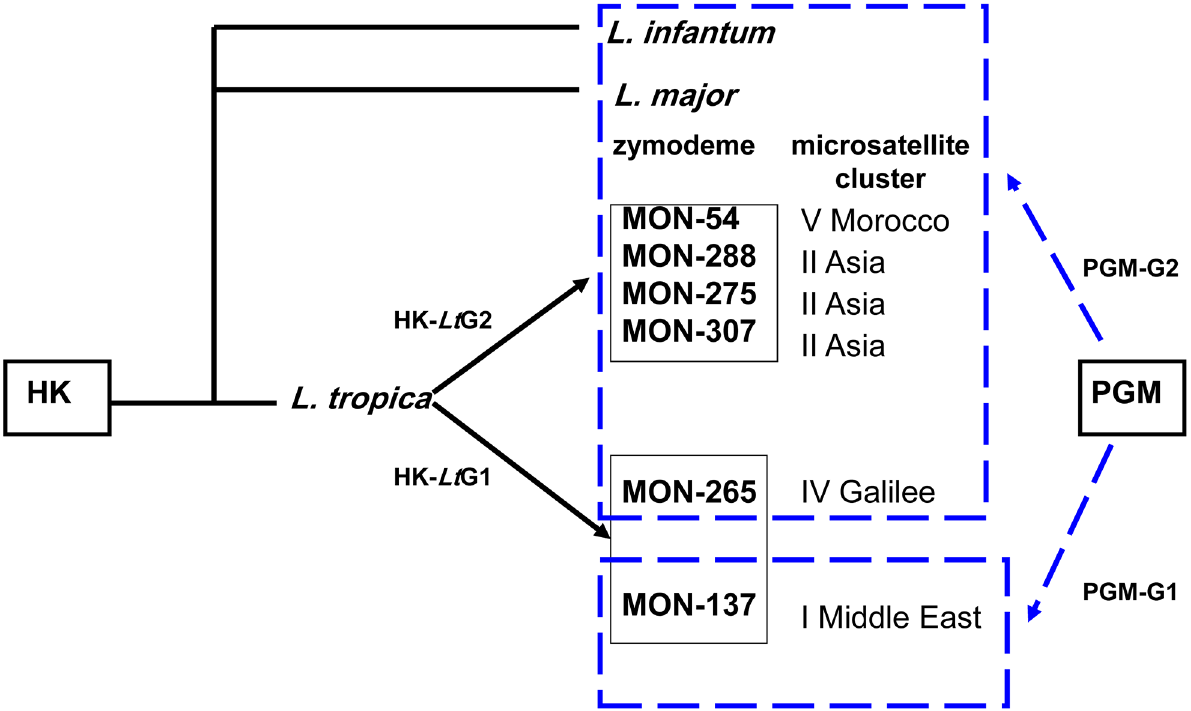
Figure 4. Scheme of the interrelationship between the genotypes derived from the PCR RFLP profiles of the chosen hexokinase gene sequence after double digestion of the PCR product with MboI and HaeIII and the phosphoglucomutase gene sequence after single digestion of the PCR product with just MboI , and their correlation to the zymodemes and microsatellite clusters encompassing Palestinian and Israeli strains of L. tropica : genotype HK- Lt G1=Hexokinase L. tropica group 1, genotype HK- Lt G2=Hexokinase L.tropica group 2, genotype PGM-G1=Phosphoglucomutase group 1, genotype PGM-G2=Phosphoglucomutase group 2. Zymodemal designations were taken from, Rioux [8] and Pratlong [7], and microsatellite clusters from Schwenkenbecher